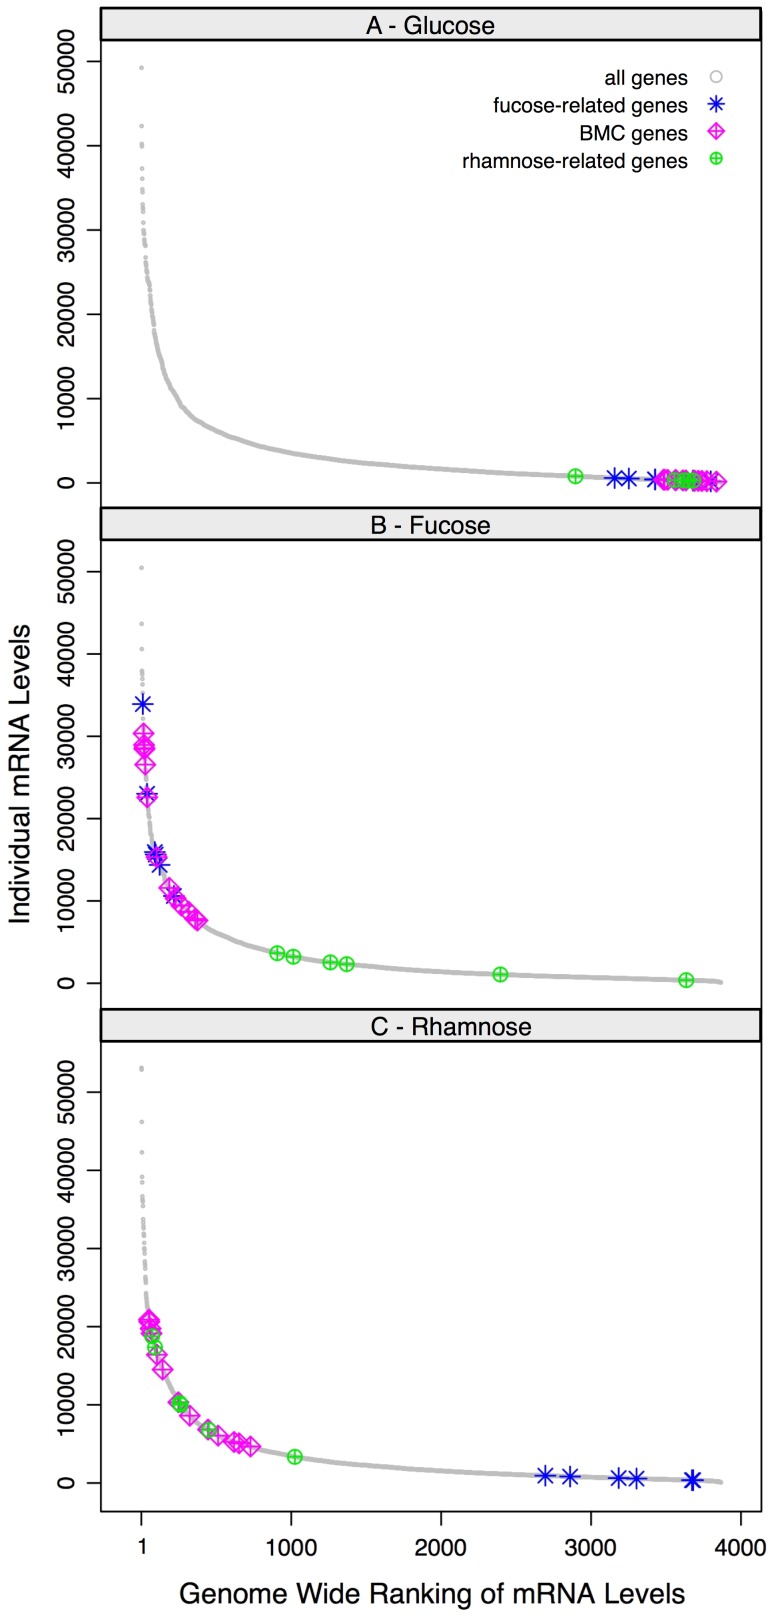
Rank abundance of mRNA expression levels.The expression levels of the BMC locus and genes involved in fucose and rhamnose transport and metabolism (fucose- and rhamnose-related, respectively) are plotted as a function of their genome-wide mRNA ranking level. The #1 ranked gene is the highest expressed protein-coding gene in the genome. Expression values are the average of two rhamnose, fucose or glucose measurements.